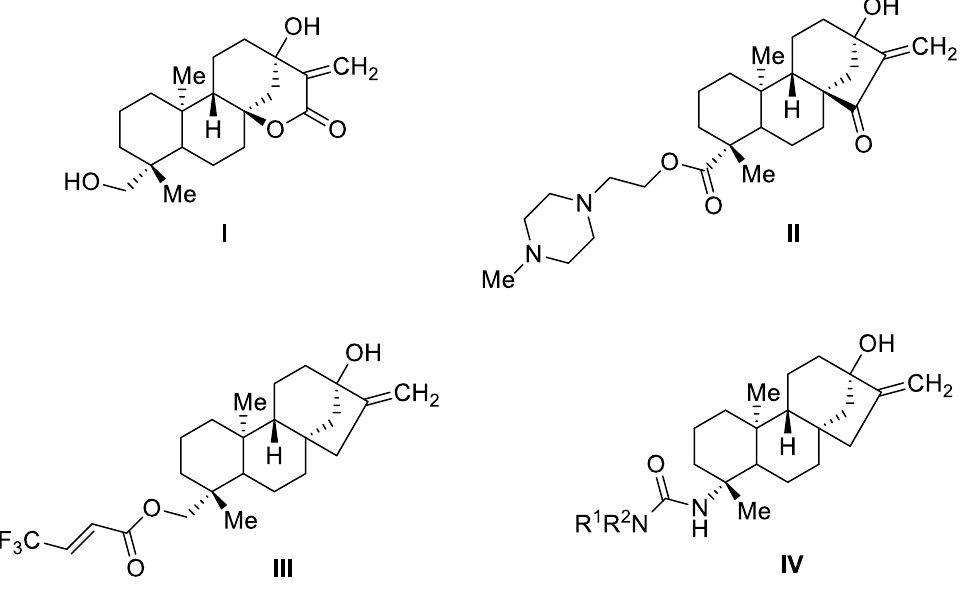
Figure 1. Examples for steviol derivatives with remarkable biological activities.